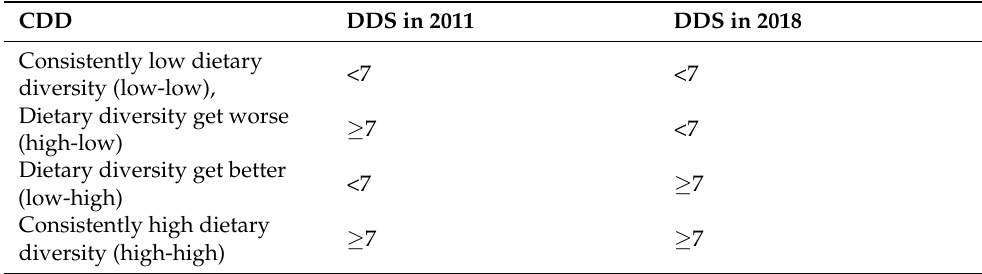
Table A2. CDD from 2011 to